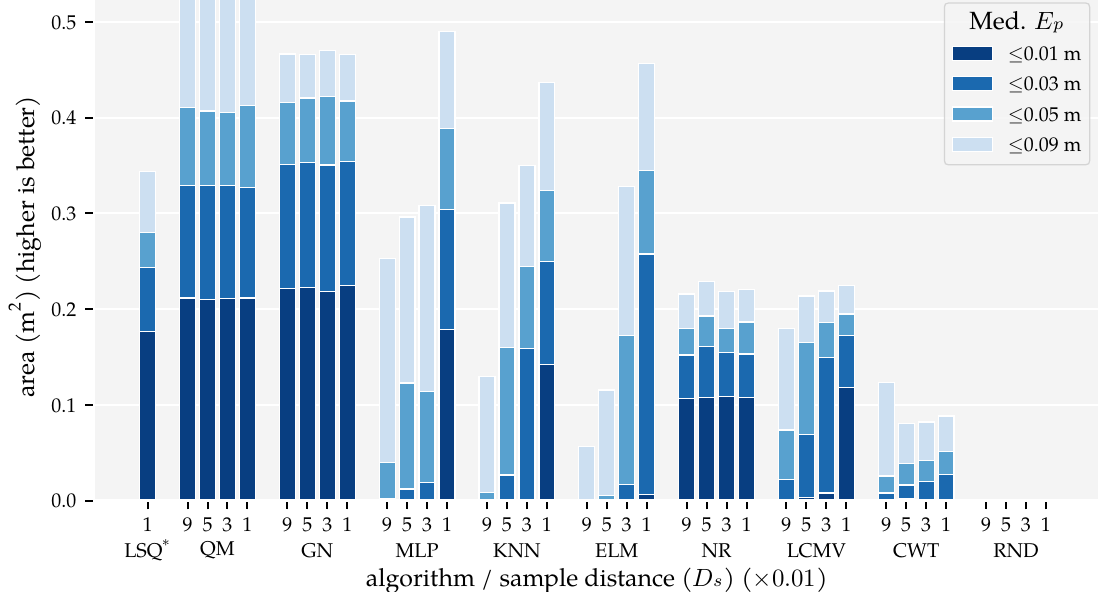
algorithm / sample distance ( 𝐷 𝑠 ) ( ×0.01 ) Figure 5. Total areas with a median position error E p (Equation (4)) below 1cm, 3cm, 5cm, and 9cm for the training and optimisation sets with a varying minimum distance between source states D s (see Section 2.3 and Table 1) and the (x + y) sensor configuration at the σ = 1.0 × 10 − 5 ms − 1 noise level. The median position error was computed for 2 × 2 cm 2 cells. Note, the bar for LSQ* is based the (x + y) condition in Analysis Method